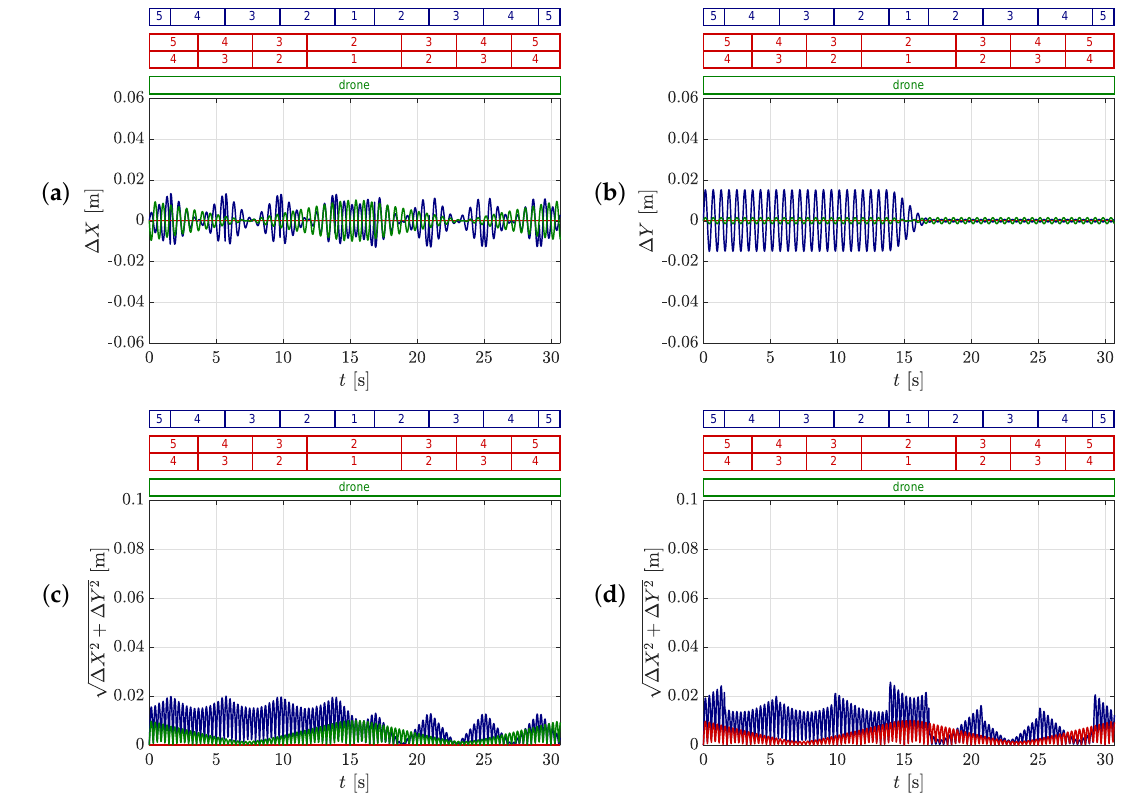
Figure 26. Overview of the systematic error induced by the vertical sway of the pedestrian’s head for the mono-vision static camera setup (blue), stereo vision static camera setup (red) and mono-vision drone camera setup (green): ( a ) longitudinal and ( b ) lateral error relative to the true trajectory, ( c ) absolute error relative to the true trajectory and ( d ) absolute difference of the trajectory obtained by the static camera setup relative to the drone camera setup.